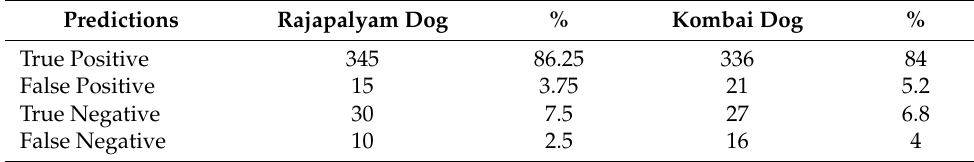
Table 2. Prediction accuracy of dog